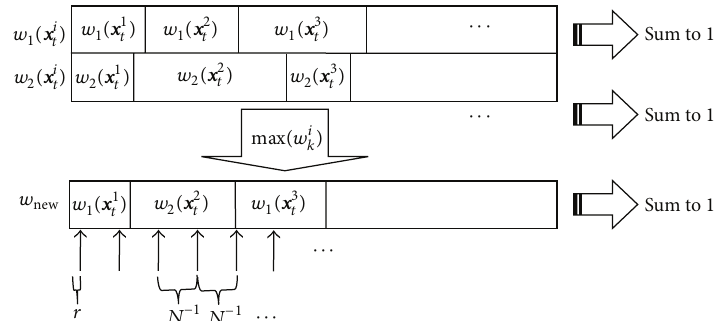
Figure 6: Resampling mechanism for multiple targets.